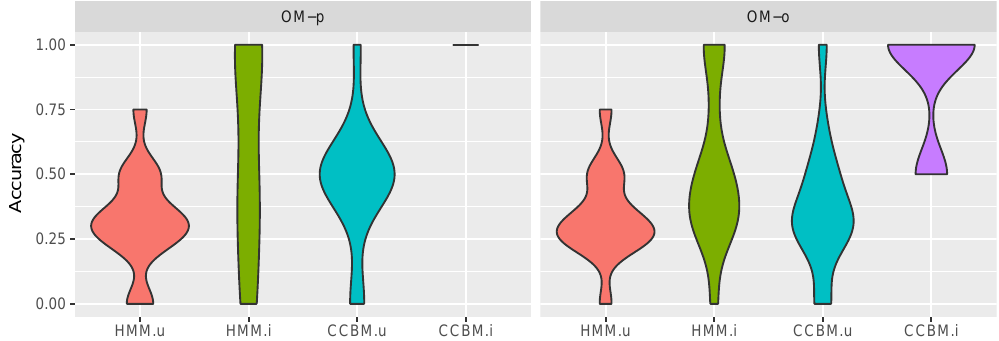
Figure 13. Multi-goal recognition results, healthy/unhealthy goals. OM-o refers to the optimistic observation model, OM-p to the pessimistic observation model, HMM.u is the HMM with uninformed a priori goal probabilities, HMM.i is the HMM with informed a priori goal probabilities, CCBM.u is the CCBM with uninformed a priori goal probabilities, and CCBM.i is the CCBM with informed a priori goal probabilities.